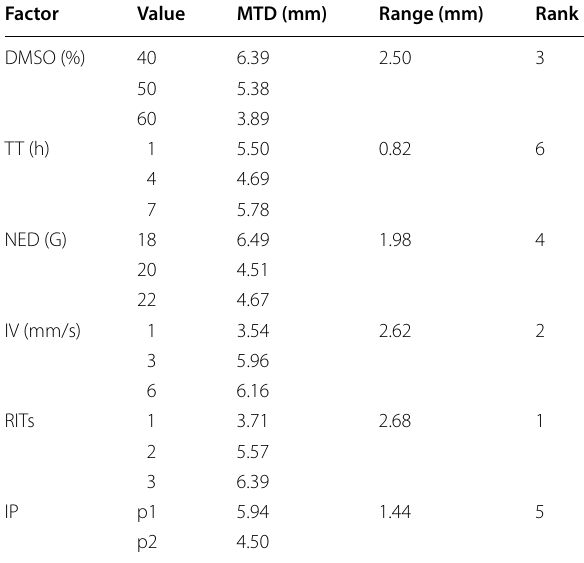
Table 4 Average value and range calculation of